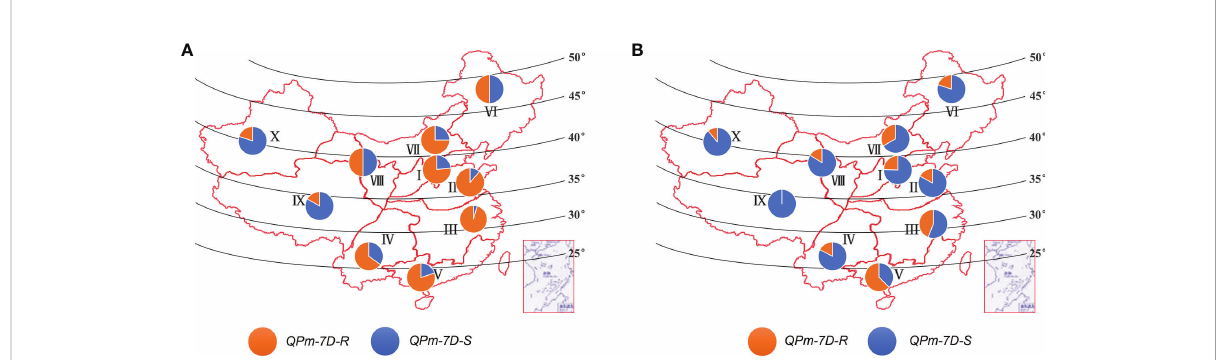
FIGURE 6 Geographic distribution of the QPm.cas-7D haplotypes among ten Chinese ecological regions. Distribution of QPm.cas-7D haplotypes in landraces (A) and modern cultivars (B) among ten Chinese ecological regions. I, northern winter wheat region; II, Yellow and Huai River valley winter wheat region; III, low and middle Yangtze River valley winter wheat region; IV, southwestern winter wheat region; V, southern winter wheat region; VI, northeastern spring wheat region; VII, northern spring wheat region; VIII, northwestern spring wheat region; IX, Qinghai – Tibet spring – winter wheat region; X, Xinjiang winter – spring wheat